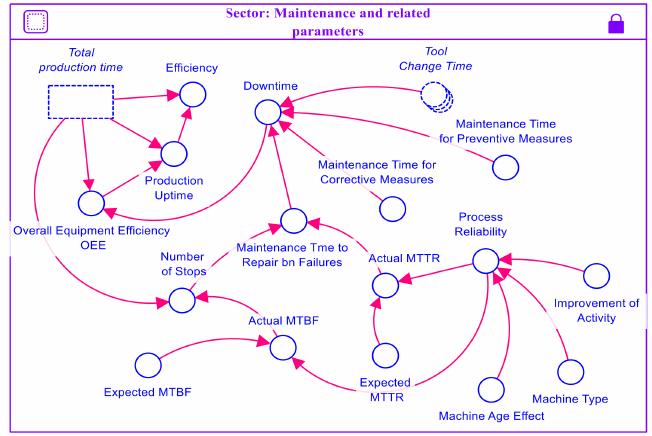
Figure 16. Structure of maintenance considering MTTR and